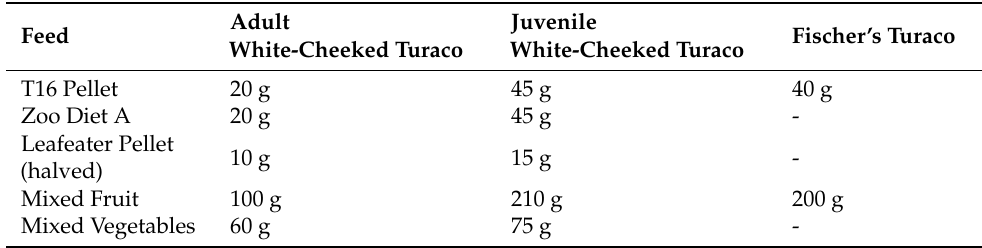
Table 3. Amounts of food provided to each group of turacos at Sparsholt College and The Liv- ing